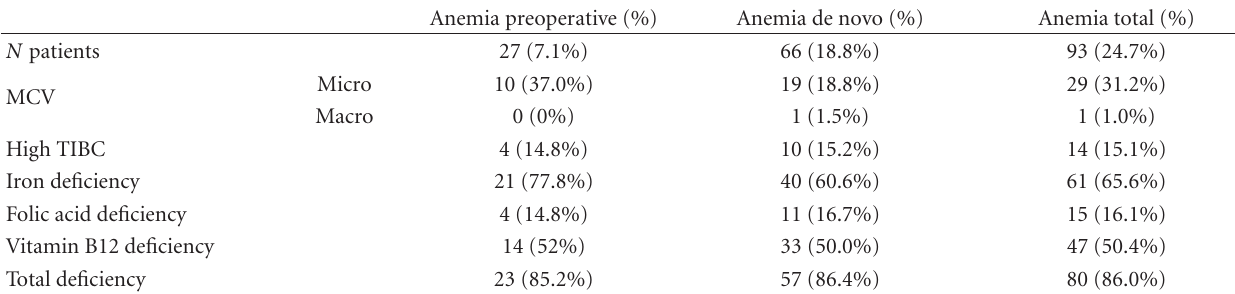
Table 3: 12 Month evaluation of anemic patients.